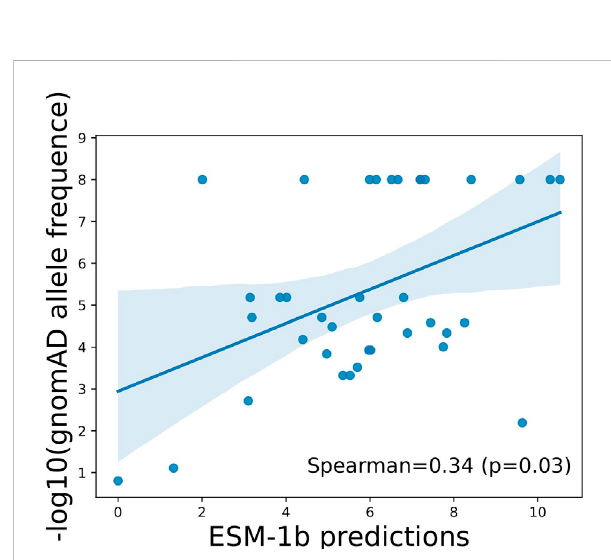
FIGURE 2 Correlation between ESM-1b predictions and population allele frequencies among ClinVar reported variants in APOE. Pearson correlation coef fi cient and associated p -value were